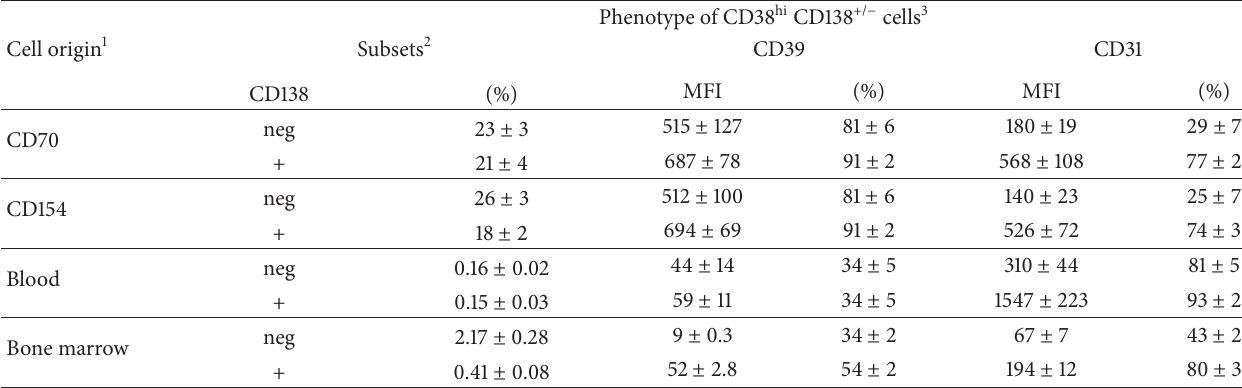
Table 1: CD31 + and CD39 + cell frequencies within plasma cells in vitro and in